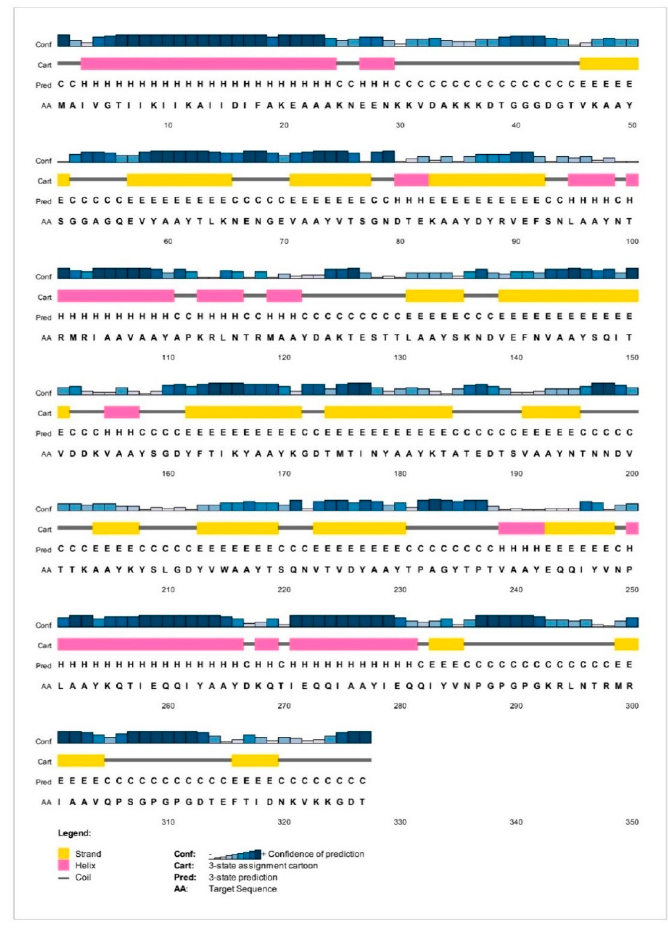
Figure 3. Secondary structure prediction of the final multi—epitope vaccine constructs by using the PSIPRED tool.